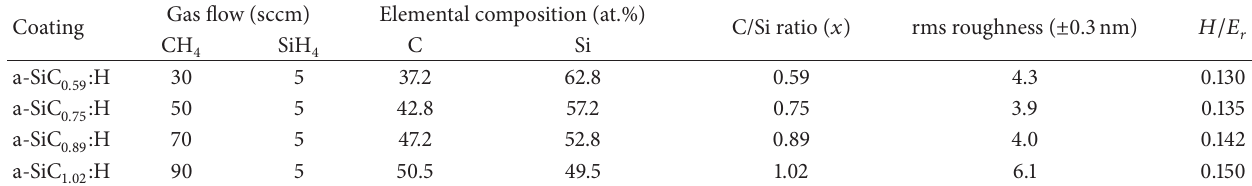
Table 1: The deposition conditions of a-SiC 𝑥 :H coatings and the corresponding elemental composition, rms roughness, and 𝐻/𝐸 𝑟 ratios. Gas flow (sccm) Elemental composition Coating